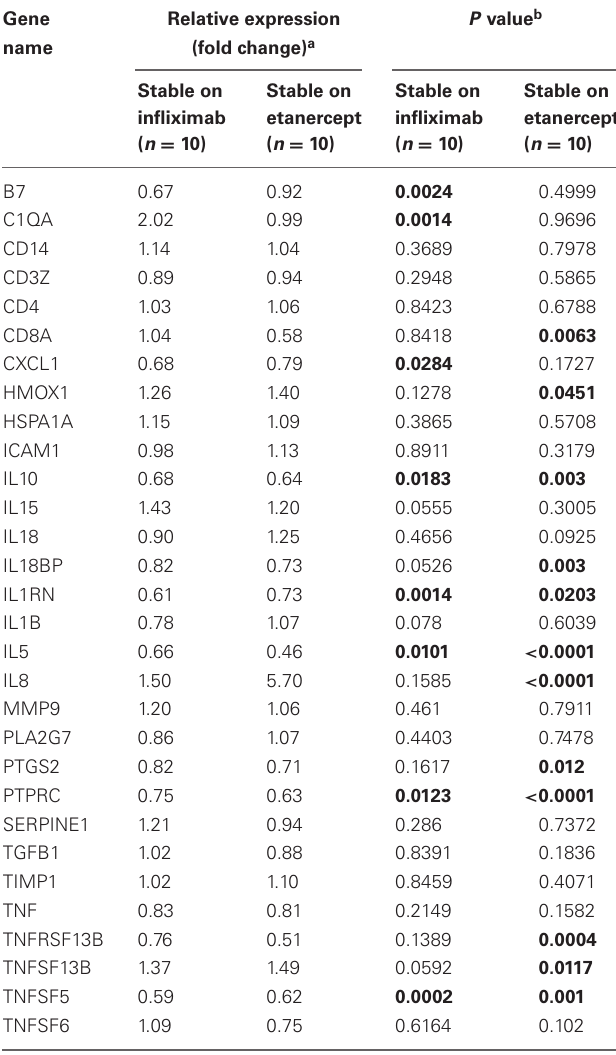
Table 4 | Single time point gene expression analysis of stable RA patients on DMARD therapy and anti-TNF- α therapy with either infliximab or